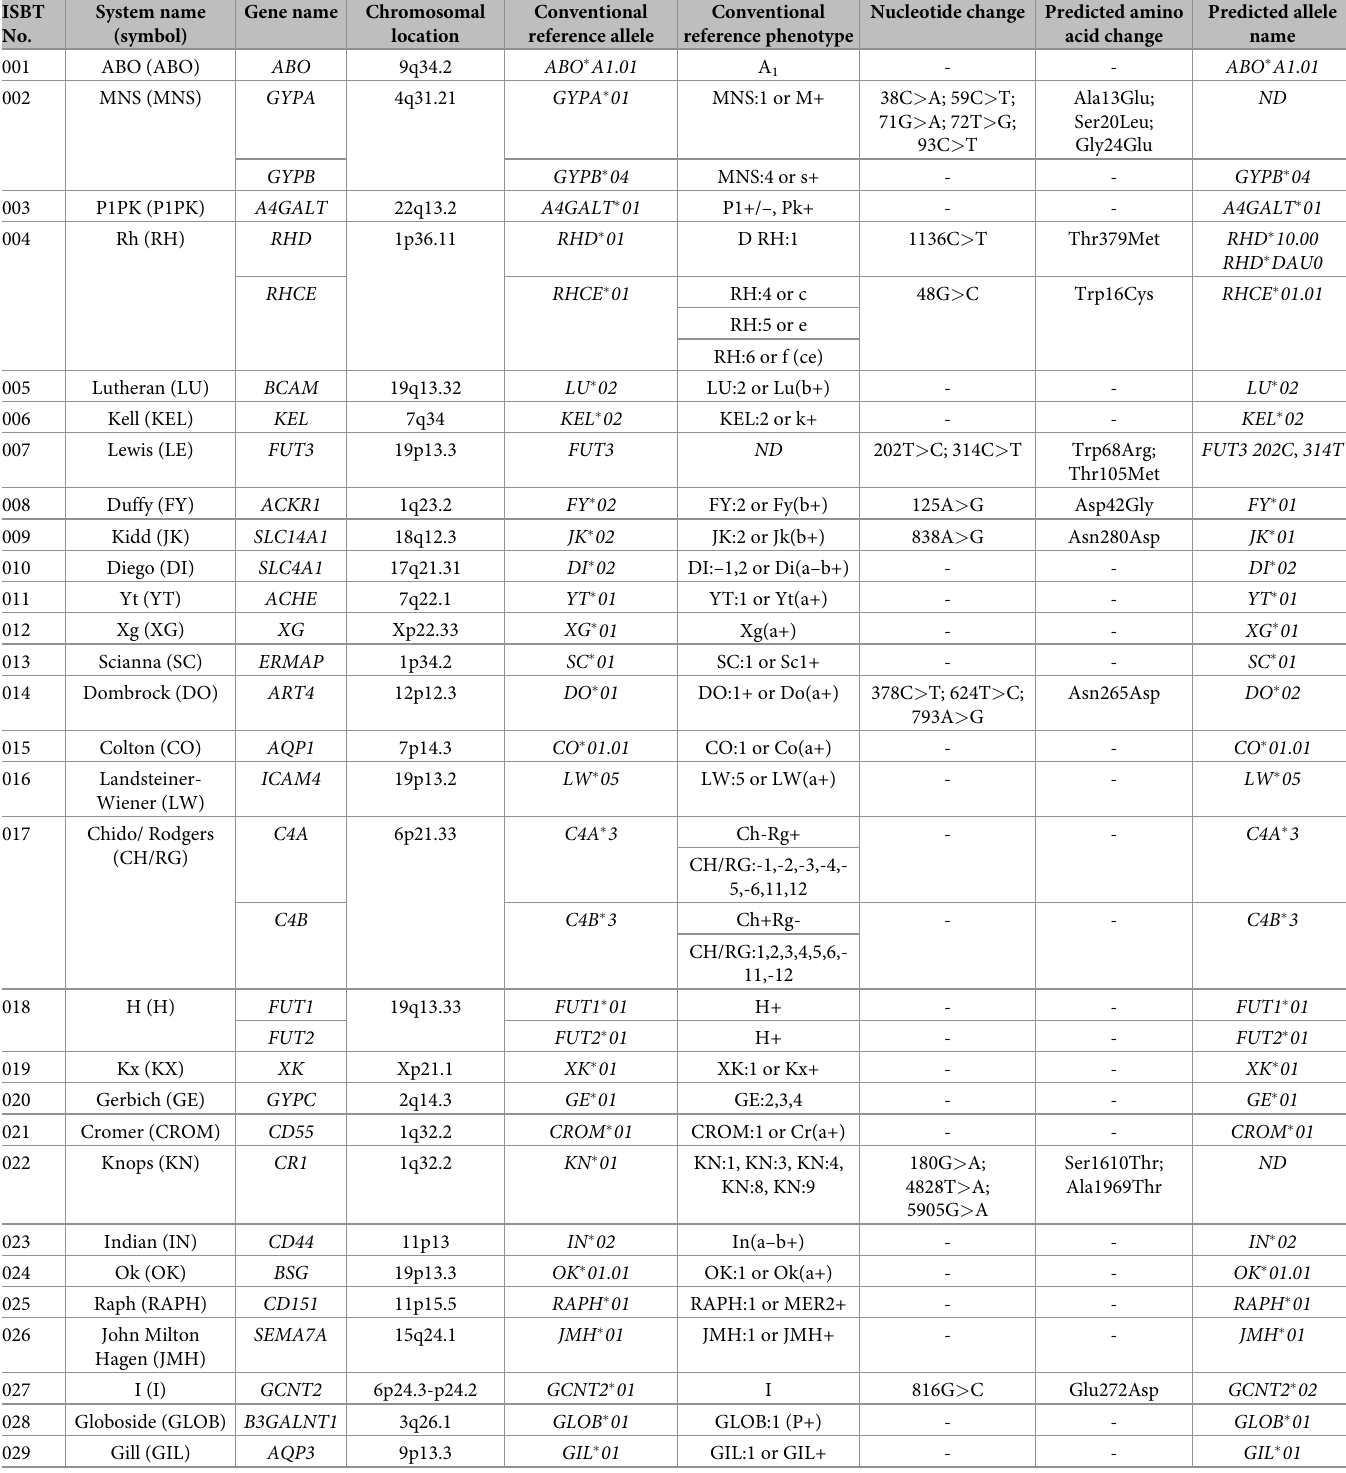
Table 1. Prediction of various blood group systems of human reference genome (hg19) compared to conventional cDNA sequences analyzed using Clustal Omega. ISBT